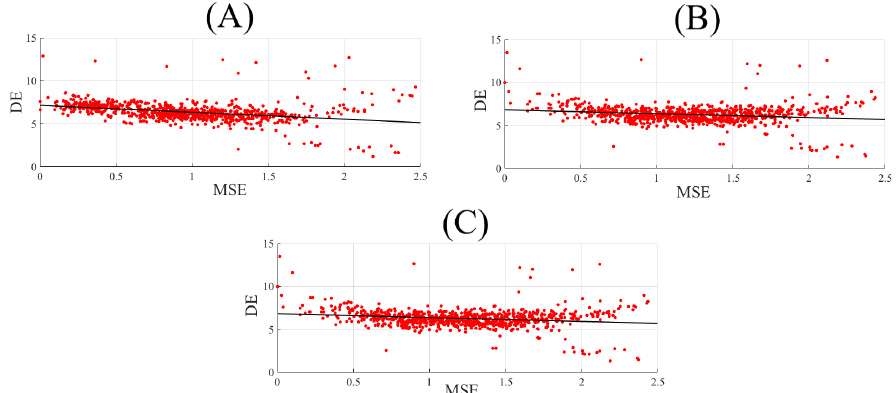
Figure 4. Spearman correlation between participants’ DEs (i.e., 62 DEs associated with 62 EEG channels of a participant, per affect) and their corresponding multiscale entropy (MSE)1 values (i.e., 62 MSE1s associated with 62 EEG channels of a participant, per affect) in ( A ) Negative ( B ) Neutral ( C ) Positive.